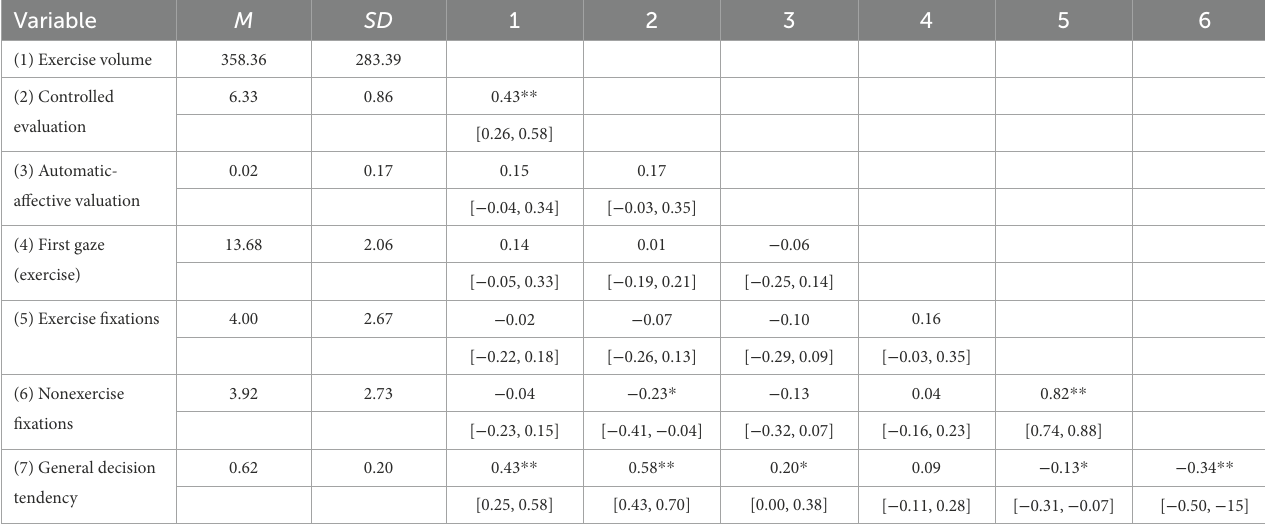
TABLE 1 Means, standard deviations, and correlations of the main variables. Variable